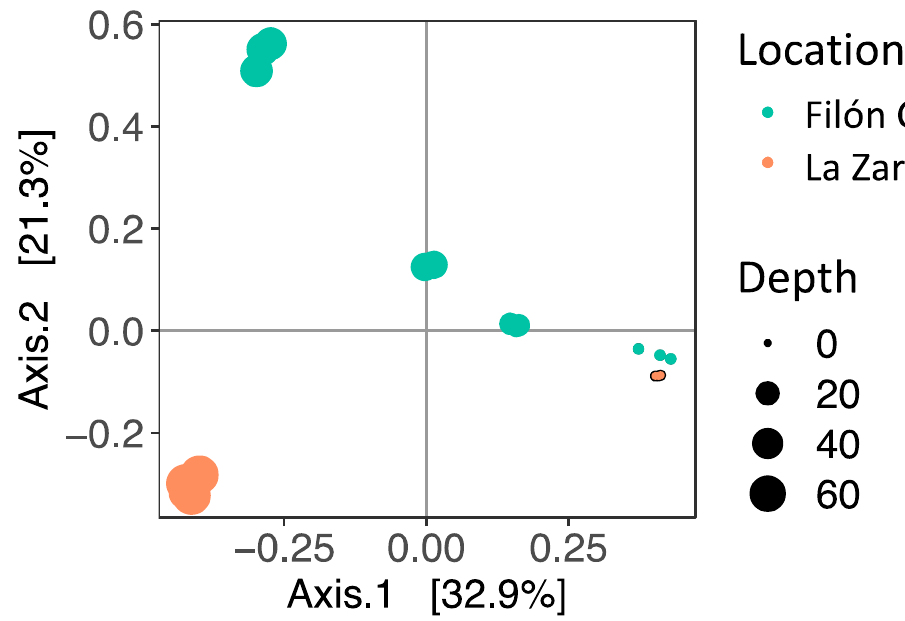
Figure 6. Ordination plot based on the Bray–Curtis dissimilarity index showing spatial separation between microbial community composition at different depths in Filón Centro (green) and La Zarza (orange).